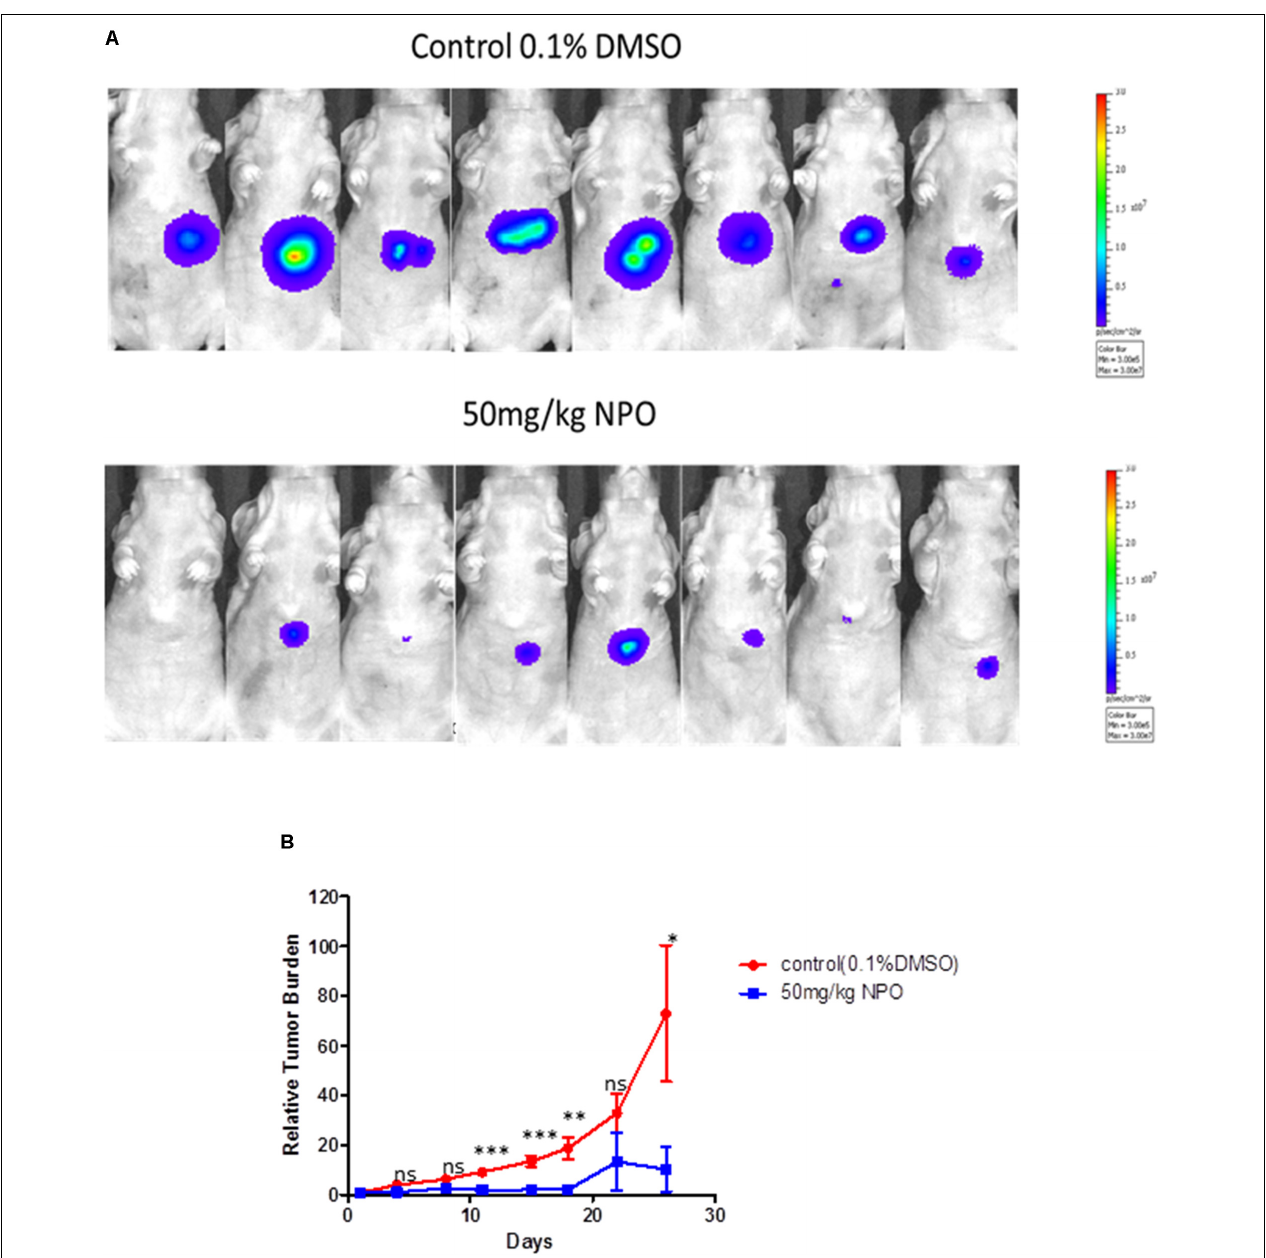
FIGURE 7 | NPO significantly abrogates tumor growth in an orthotopic mouse model. (A) Bioluminescence images of orthotopic tumor bearing mice. Ncr nude mice were orthotopically implanted with HCCLM3_Luc cells and then treated with 0.1% DMSO ( n = 8) or 50 mg/kg NPO ( n = 8) for 26 days. (B) The scatter plot represents the differences in tumor burden between control and NPO treated mice and is expressed as tumor burden relative to photon counts. The statistics was determined using unpaired t test with Welch’s correction. ∗ p < 0.05; ∗∗ p < 0.01; ∗∗∗ p <